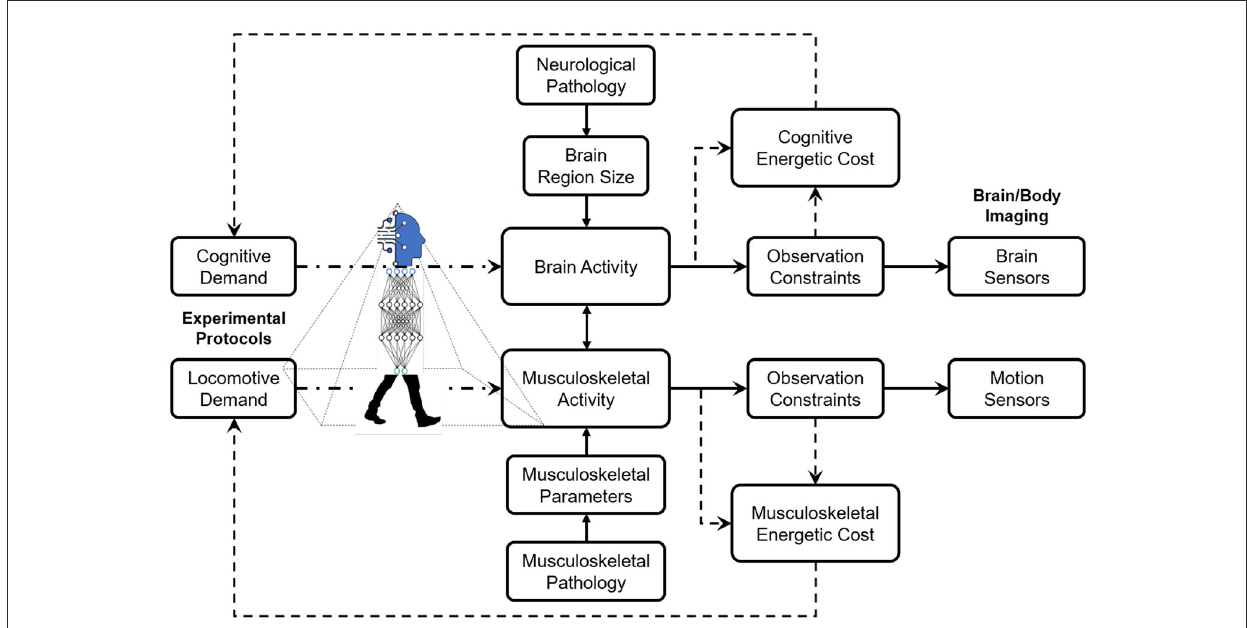
FIGURE1 The design methodology of experimental protocols is based on comprehensive considerations of cognitive and locomotive demands, observation constraints by the sensing technology, and energetic costs determined by the human